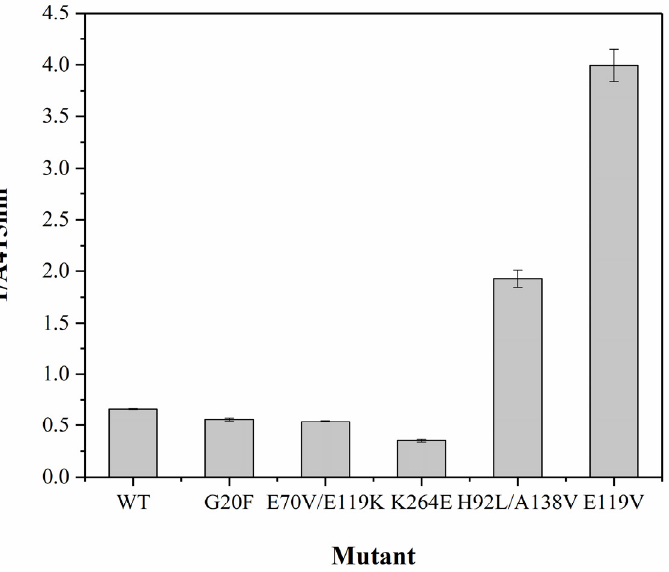
Figure 1. The re-screening results of WT, G20F, E70V/E119K, K264E, H92L/A138V, and E119V show that H92L/A138V and E119V are better than the WT (the higher the value of 1/A 415nm , the higher the catalytic efficiency).